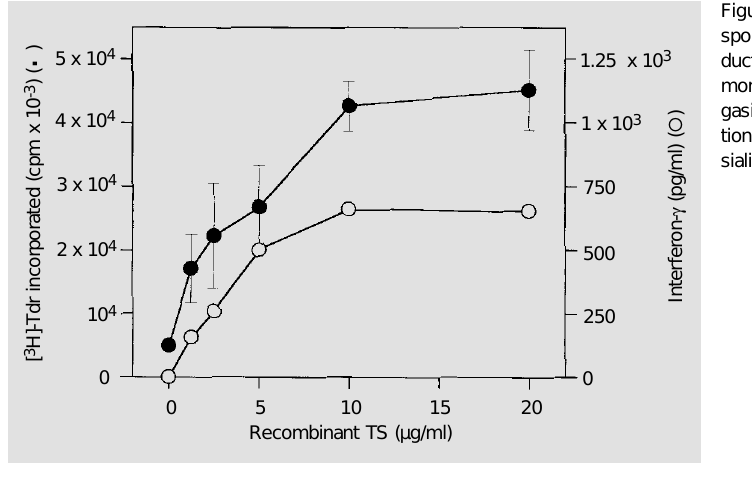
Figure 3 - Proliferative re- sponse and interferon- g pro- duction by peripheral blood mononuclear cells of a